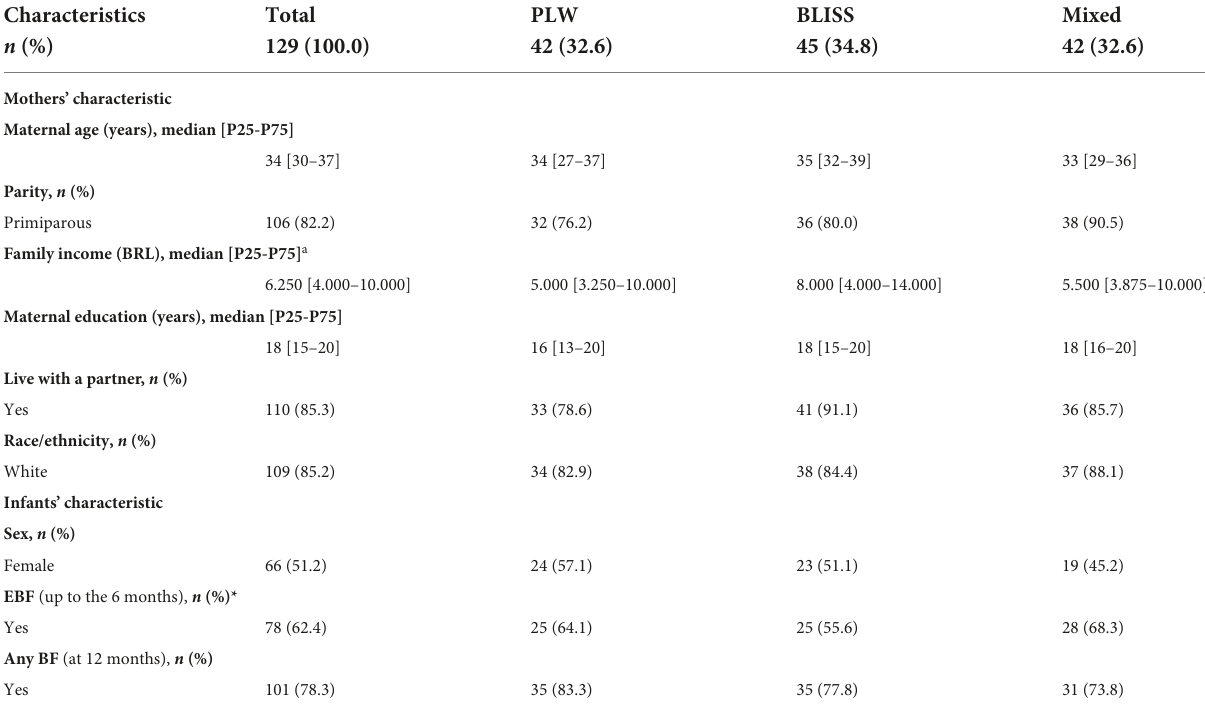
TABLE 1 Characteristics of mothers and infants according to interventions groups, Brazil, 2019–2021.